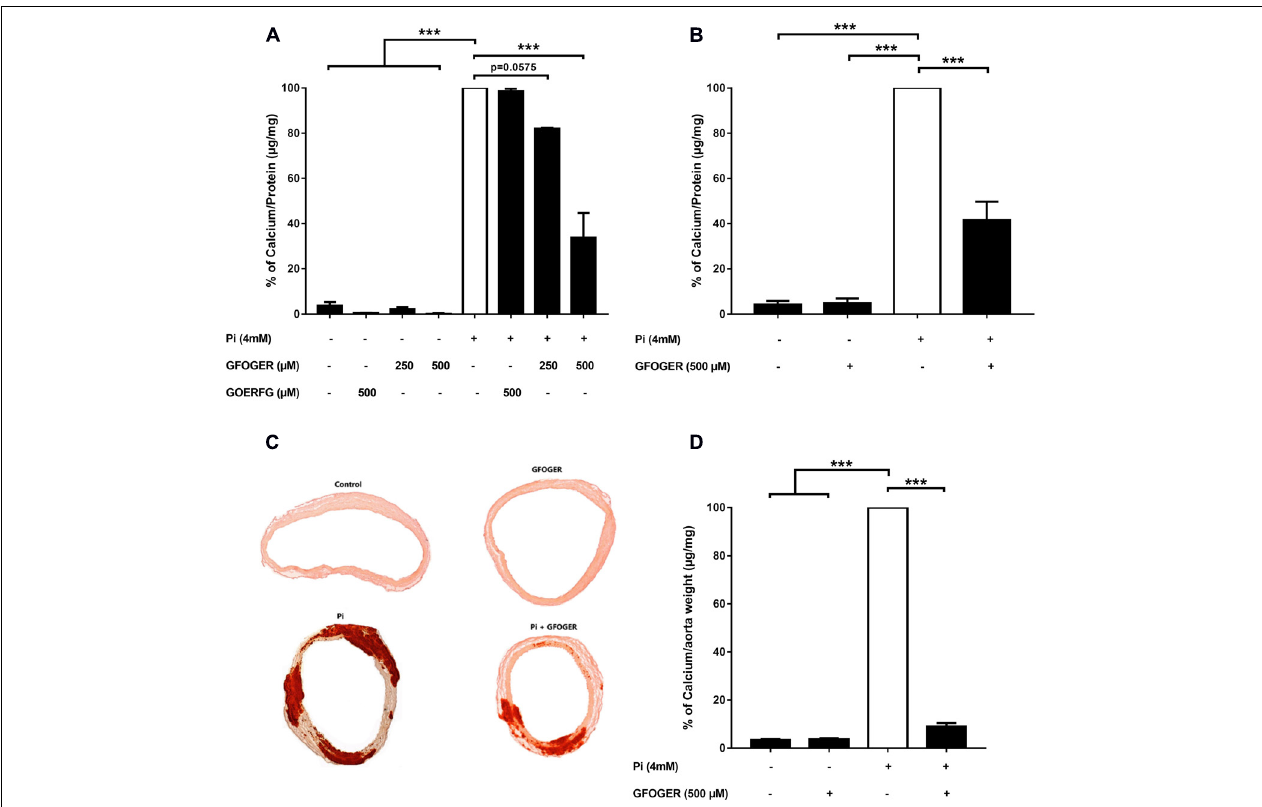
FIGURE 2 | GFOGER peptide inhibits Pi-induced calcification: (A,B) in smooth muscle cells. Calcification in smooth muscle cells was induced by incubation with 4 mM Pi in absence or presence of GFOGER peptide or GOERFG peptide. (A) MOVAS cells were incubated with two concentrations of GFOGER peptide (250 and 500 µ M) or with 500 µ M of GOERFG peptide for 10 days. (B) Primary human vascular smooth muscle cells were incubated with 500 µ M of GFOGER peptide for 14 days. Calcification was then measured using the OCP method. (C,D) In rat aortic rings. Rat aortic rings were incubated with 4 mM Pi in presence or absence of 500 µ M GFOGER peptide for 10 days. (C) Images of one representative Alizarin Red staining experiment are shown. (D) Intracellular calcium content was quantified by OCP colorimetric method. Data are expressed as mean ± SEM of three independent experiments done in triplicate ( n = 3). *** p < 0.001 vs. 4 mM Pi. Parametric one-way ANOVA